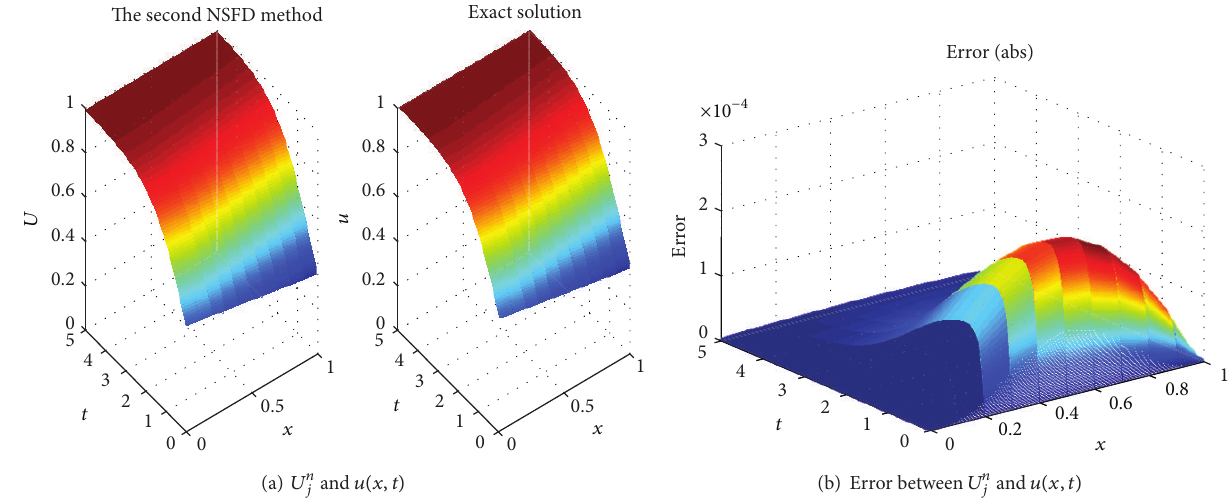
Figure 3: Simulations of NSFD scheme (41) for (5) with stepsize Δ𝑡 = 0.001 and ℎ = 0.1 .